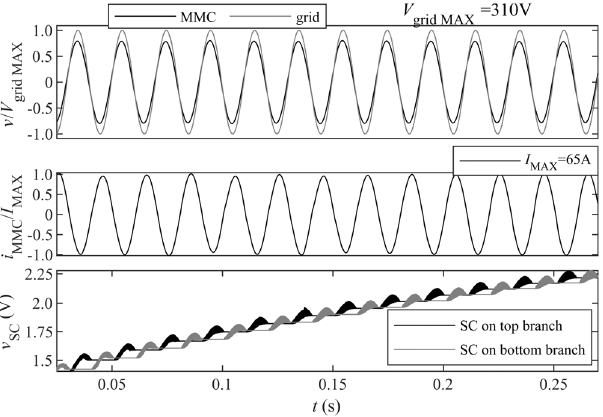
Figure 14. Boost-mode recharging the SCs.